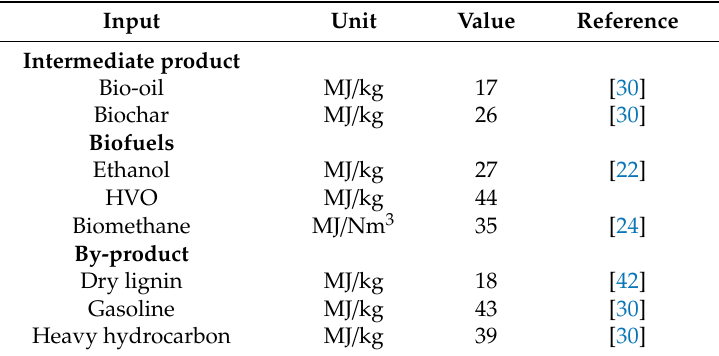
Table A5. Lower Heating Value of the intermediate product, main product (biofuel), and by-products of three